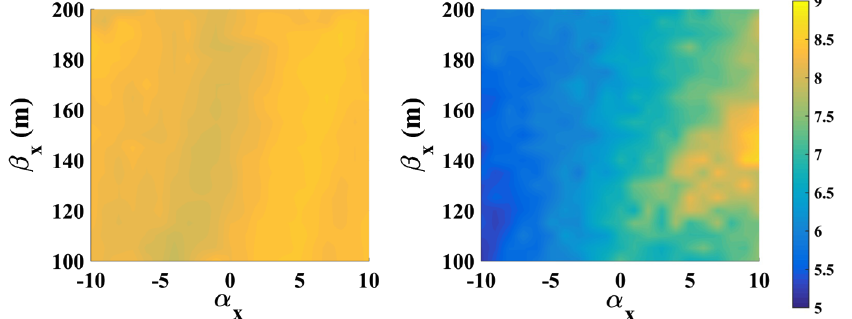
FIG. 3. The transformer ratio of the triangular current profile as a function of the Courant-Snyder parameters at the entrance of an emittance exchange beam line calculated by the linear matrix beam transport (left) and GPT simulation